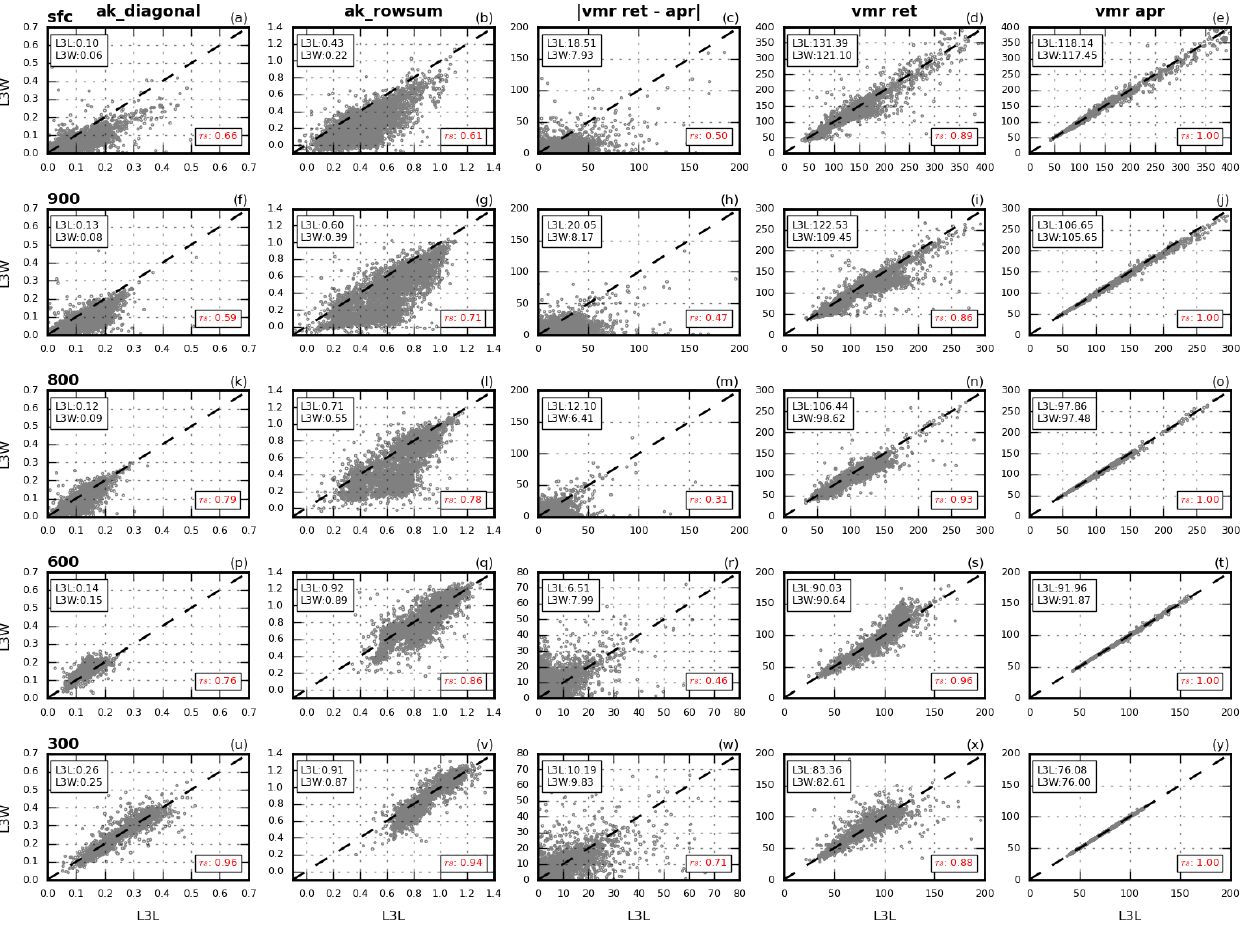
Figure 4. Mean sensitivity metrics and VMRs (retrieved and a priori) from coastal L3 grid boxes. Values compared in the scatterplots are mean values from matched L3L and L3W retrievals within these grid boxes. Matched means that only days when both L3L and L3W are present and the L3O surface index is mixed are used to create the mean values analysed. Shown are AK diagonal values (left column), AK row sums (second column), absolute VMR retrieved minus a priori values (third column; note that for ease of interpretation, the absolute retrieved minus a priori VMR values are plotted, i.e. ignoring whether the result is positive or negative; however, the results hold if using signed values, and a duplicate of Fig. 4 with signed retrieved minus a priori VMR values is included in Sect. S4 for reference), and retrieved (fourth column) and a priori (fifth column) VMRs, for the following levels of the retrieved profile: surface (top row), 900hPa (second row), 800hPa (third row), 600hPa (fourth row), and 300hPa (bottom row). Values in boxes in the top-left corner of each panel correspond to mean values across all L3L and L3W grid boxes. These means are significantly different using a two-tailed t test (unequal variance) with p < 0.005 in all cases except ak_diagonal at 300hPa where p = 0.13, vmr_ret_minus_apr at 300hPa where p = 0.07, vmr_ret at 600hPa where p = 0.30, and vmr_ret at 300hPa where p = 0.11. No vmr_apr mean differences are significant. Values in the bottom-right corner of each panel correspond to Spearman’s rank correlation coefficient ( p < 0.005 in all